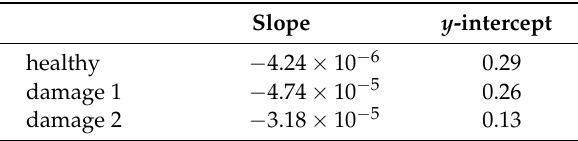
Figure 5. Results of the spectral entropy (SE) calculation for the PE signal from the raw vibration signal for all scenarios at 5 rpm. ( a ) Values for each rotation of the bearing. ( b ) Box plot for statistical analysis of the calculated values. Table 1. Linear regressions for all the scenarios at 5 rpm.